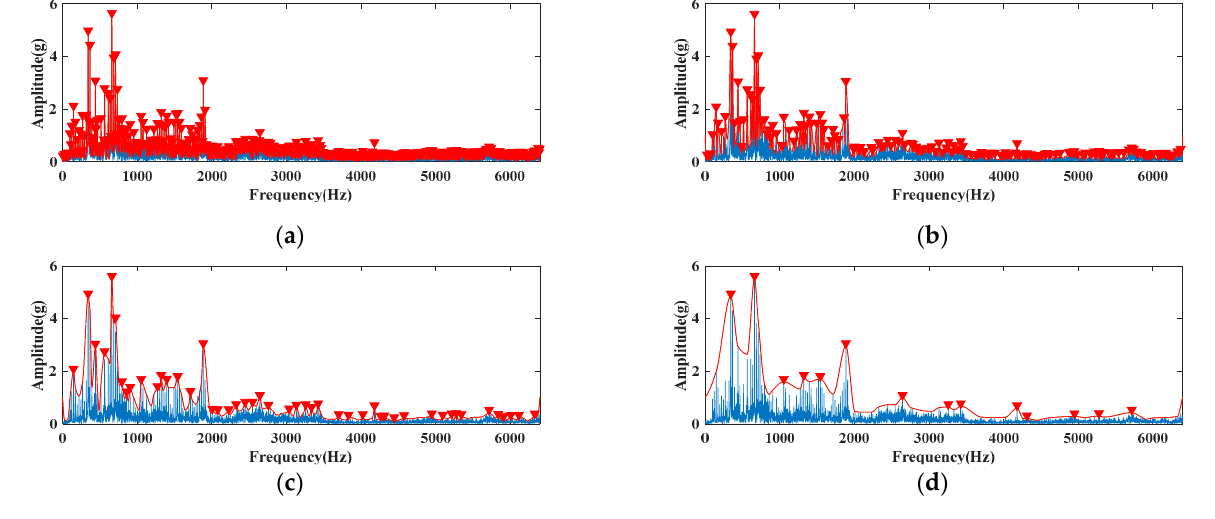
Figure 14. Experimental signal of bearing inner race single fault: ( a ) waveform; ( b ) frequency spectrum; ( c ) envelope spectrum.